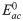
Cyclic voltammetric analysis of P450c17, wt cyt b5, E48G/E49G cyt b5 and sequential additions.
a, c, d.c. voltammograms and b, d, the 6th harmonic of the a.c. voltammograms for the bare (grey; left axis) and modified CNT electrodes. a, b, Adsorption of hemin (black, right axes) produced a much larger faradaic current and an Eac0 value (dashed lines) that were at least 0.02 V more negative than those derived from adsorption of proteins (left axes): wt cyt b5 (green), E48G/E49G cyt b5 (red) or P450c17 (blue). c, Adsorption of E48G/E49G cyt b5 on P450c17/CNT (blue) produced a substantial increase in the surface concentration of hemin (orange), but negligible changes in Γ were derived from adsorption of wt cyt b5 (magenta) on P450c17/CNT. d, The faradaic current in the a.c. components for P450c17 (blue) was suppressed upon interaction with wt cyt b5 (magenta); the a.c. data for wt cyt b5 (green) is shown as a control. (e) Schematic representation of the modes of interaction of the wt cyt b5 and the E48G/E49G cyt b5 with the P450c17/CNT electrode. All currents were normalized to the geometric electrode surface area (a-c) or to the amount of electroactive heme (d); The electrolyte solution in each case was a deoxygenated aqueous 0.20 M NaCl+0.02 M (K2HPO4+KH2PO4), pH = 7.0.